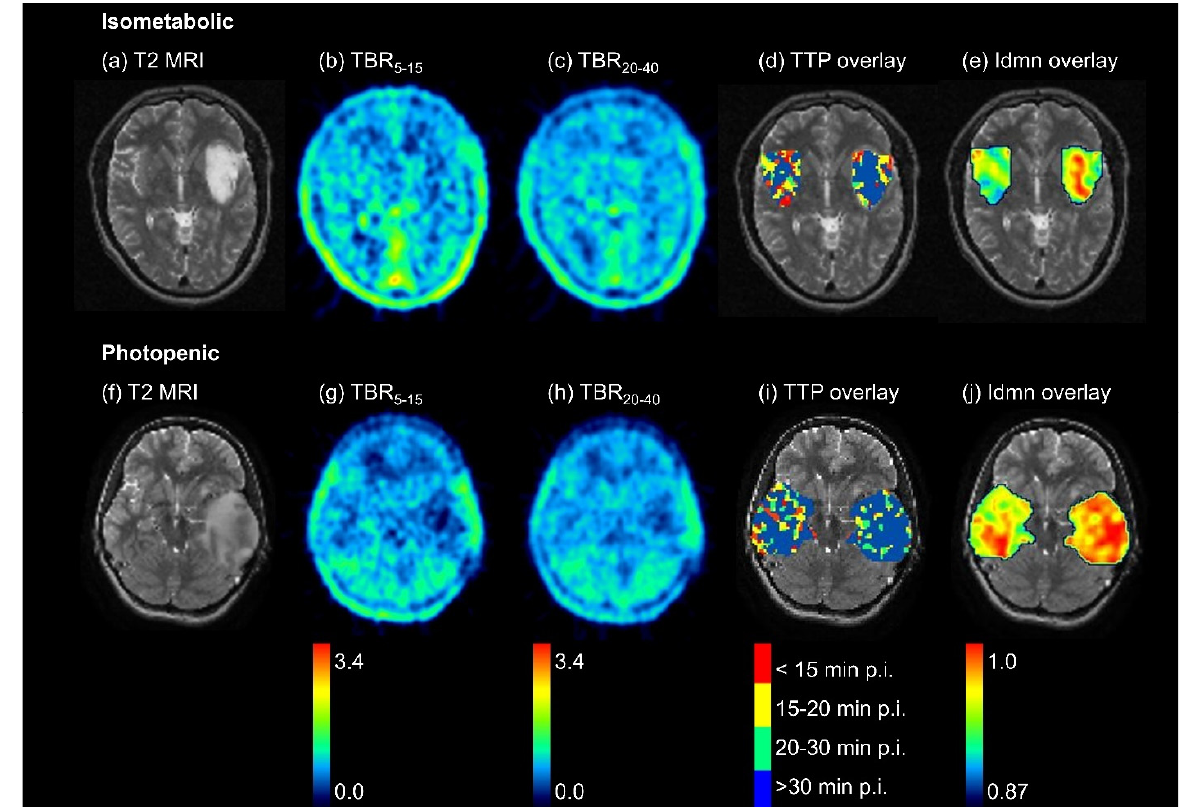
Figure 2. Example of an isometabolic glioma which cannot be identified visually in static TBR images ( b , c ) and a photopenic glioma with decreased signal in static TBR images ( g , h ). Tumor volumes were defined in T2-weighted MRI images ( a , f ). Dynamic analyses reveal differences between tumor and the mirrored volume in healthy tissue with predominantly late TTP (blue in TTP overlay, ( d , i )) and higher uniformity of TTP values according to the feature inverse difference moment normalized (Idmn, ( e , j )) in the tumor volume. For visualization, the 3D feature map for Idmn was calculated on a voxel-wise basis, taking into account a volume of 5 × 5 × 5 voxels around the centering voxel.